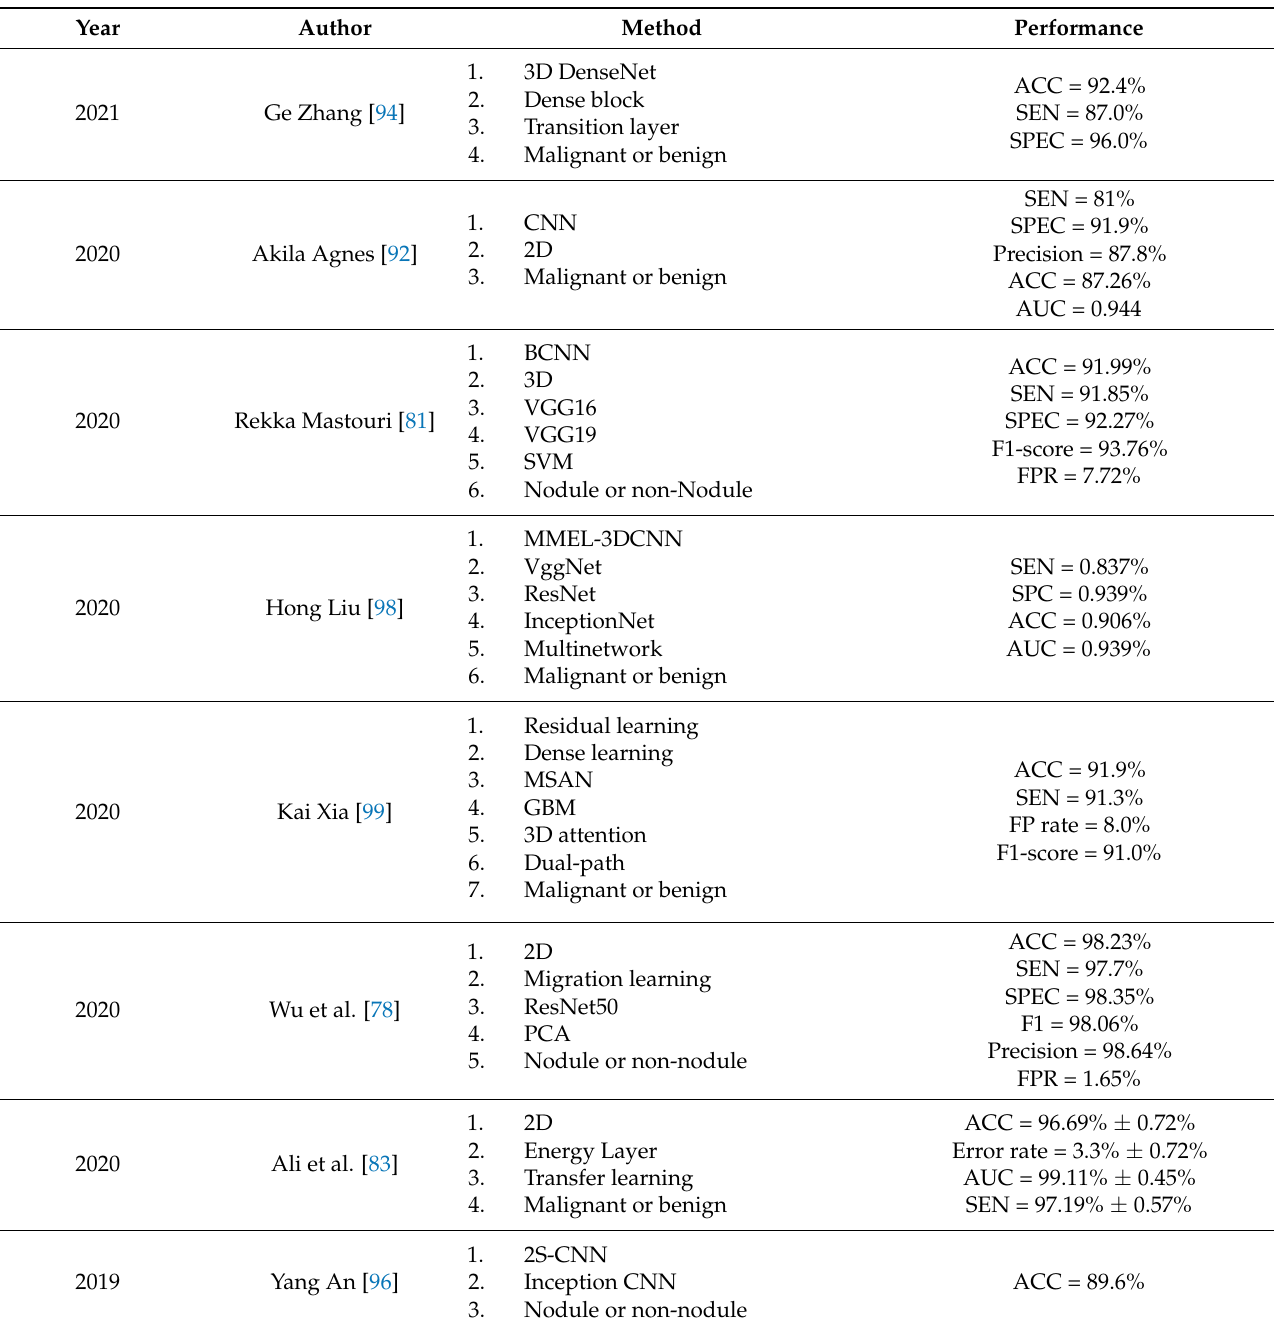
Table 4. Overview of lung nodule classification architectures and their key